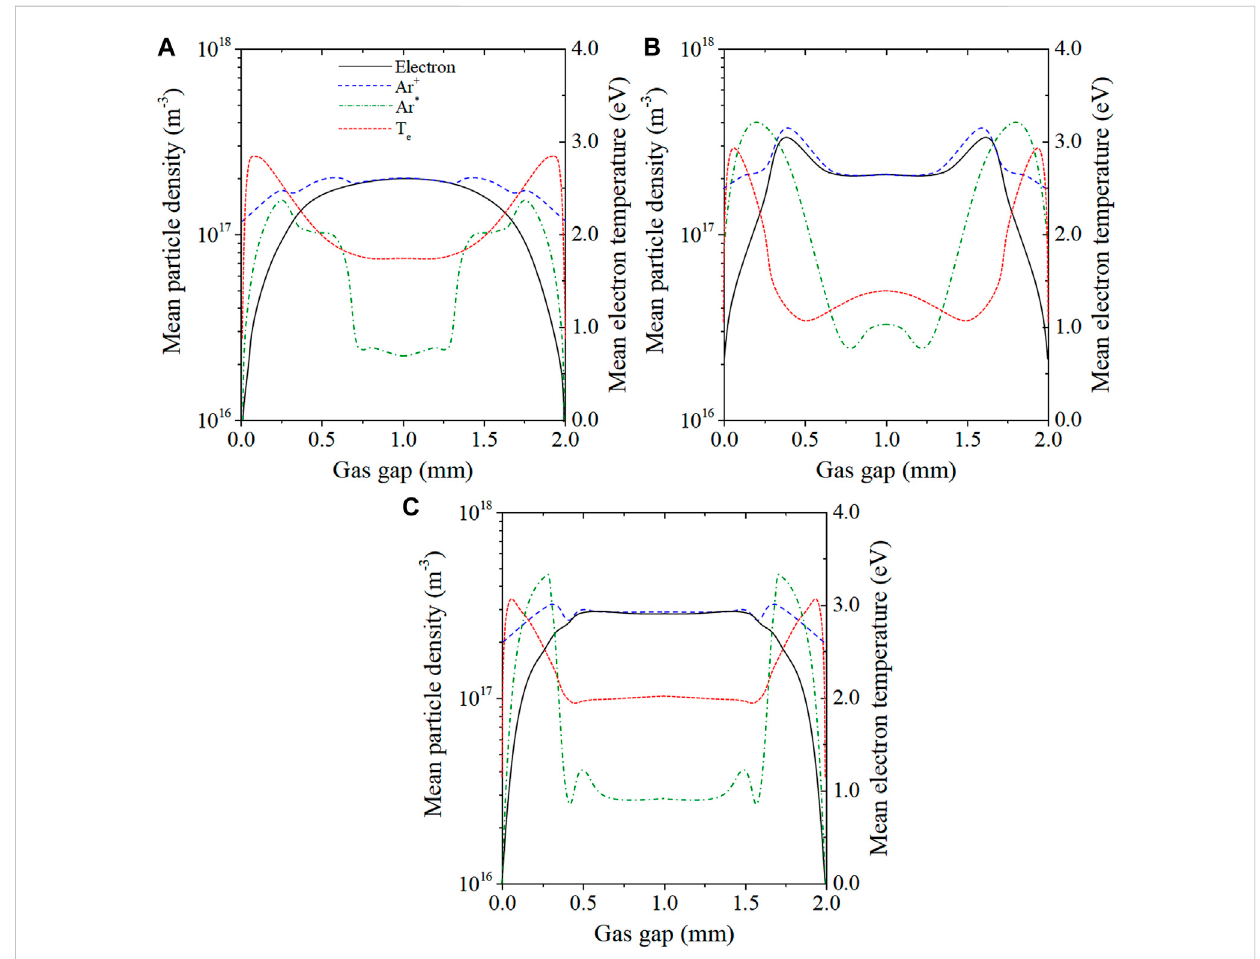
FIGURE 4 Time-averaged spatial distributions of particle densities and the electron temperature in (A) the LF-dominant mode of V LF = 0.85 kV/ V RF = 0.15 kV, (B) the DF-comparable mode of V LF = 0.7 kV/ V RF = 0.3 kV, and (C) the HF-dominant mode of V LF = 0.1 kV/ V RF = 0.4